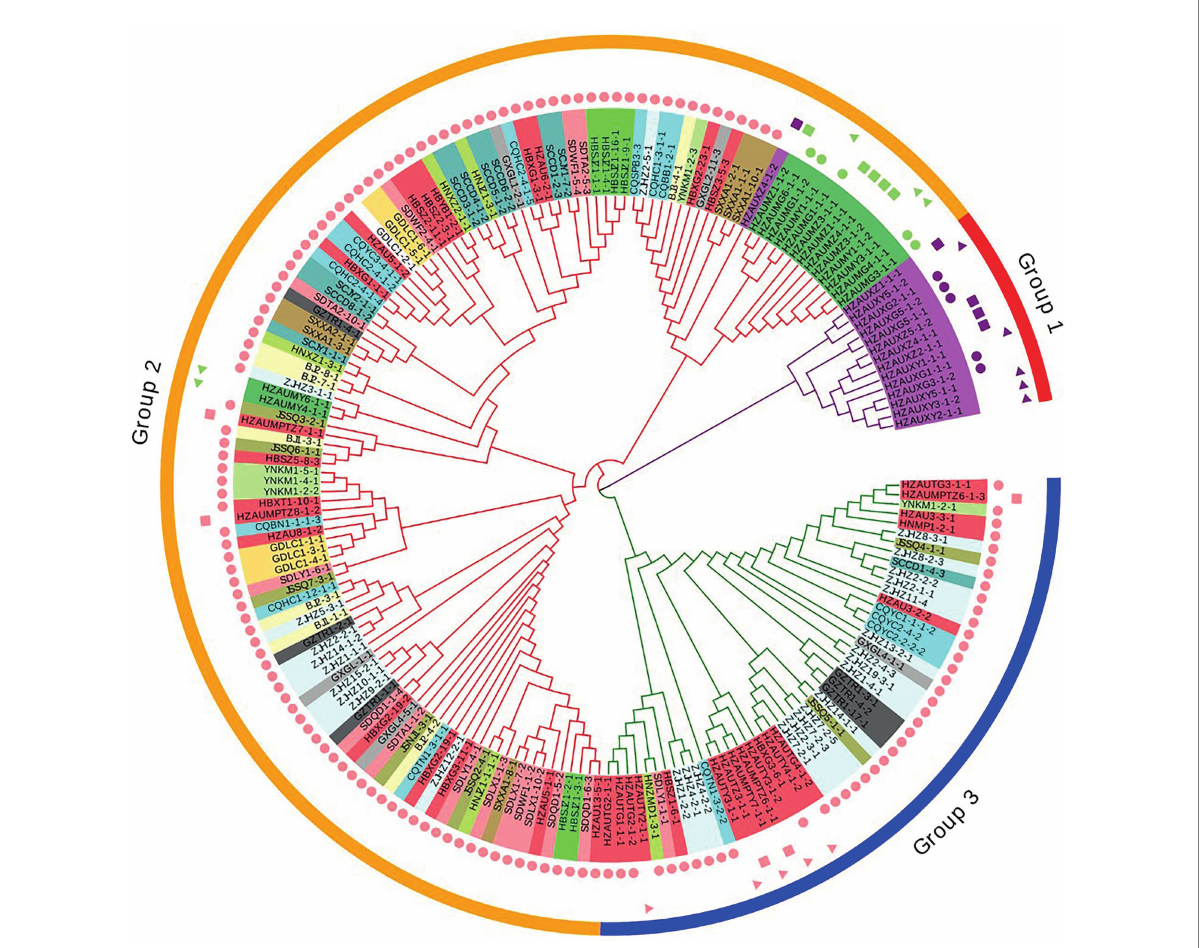
FIGURE 9 Relationships among 186 Venturia carpophila isolates from 14 provinces and 3 hosts. The dendrogram was constructed using the unweighted pair group method with arithmetic mean based on Nei’s genetic distance. Shape labels, circle: isolates from fruits, rectangle: isolates from twigs and triangle: isolates from leaves. Color labels, pink: isolates from peach, green: isolates from mume and purple: isolates from apricot. Phylogenetic tree was managed and annotated by using Evolview